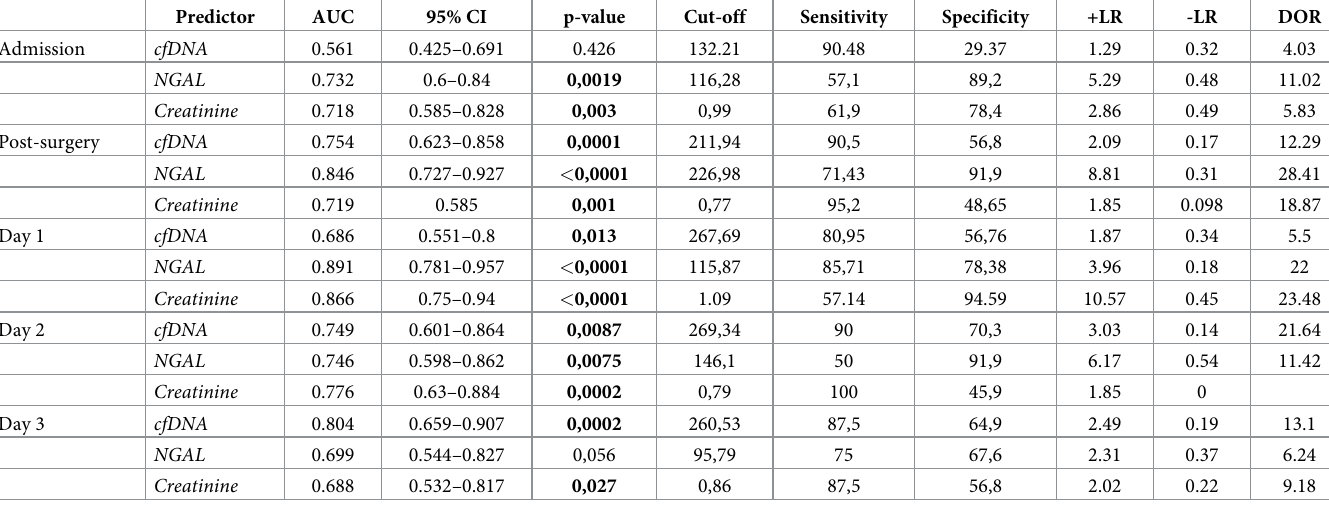
AKI, acute kidney injury; AUC, area under curve; cfDNA, cell-free DNA; CI, confidence interval; DOR, diagnostic odds ratio; LR, likelihood ratio; NGAL, neutrophil gelatinase-associated